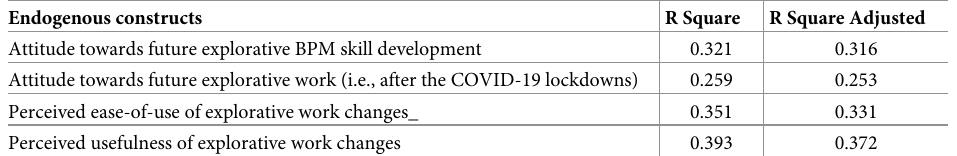
Table 8. Coefficient of determination ( R 2